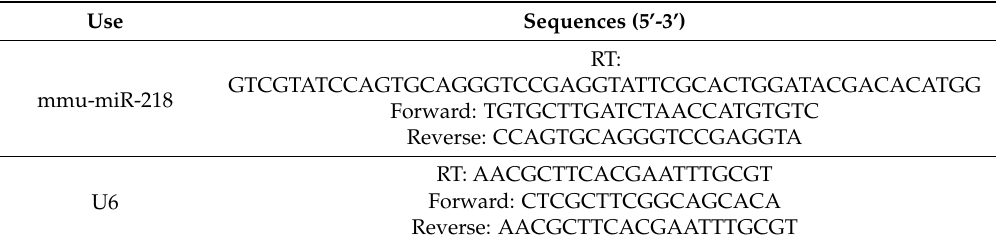
Table 2. Primers of miR-218 and